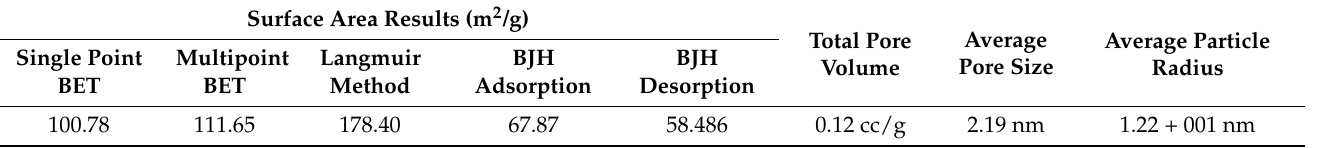
Table 1. Textural properties of S. latifolium as determined by N 2 adsorption. Surface Area Results (m 2